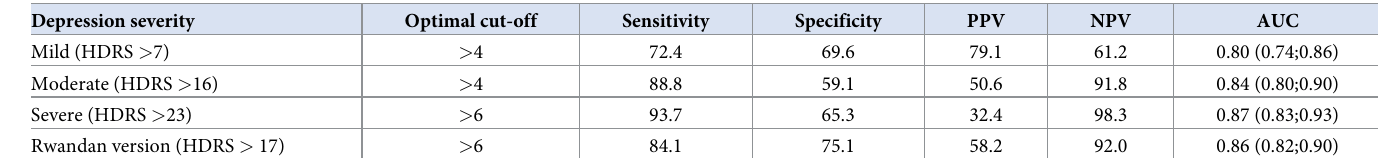
Table 4. Receiver operating characteristic curves of the PHQ-9 scores in relation to HDRS categories: Mild, moderate, severe.